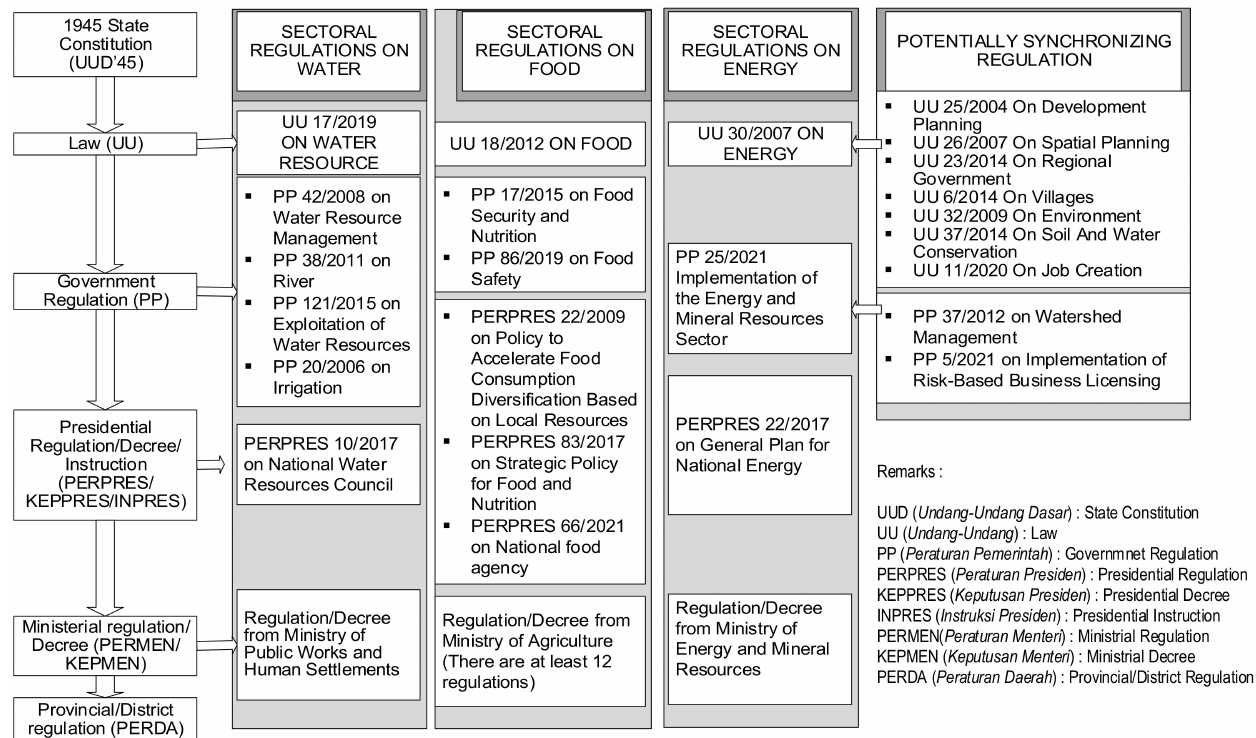
Figure 2. The Indonesian regulatory system’s hierarchy for water, food, and energy